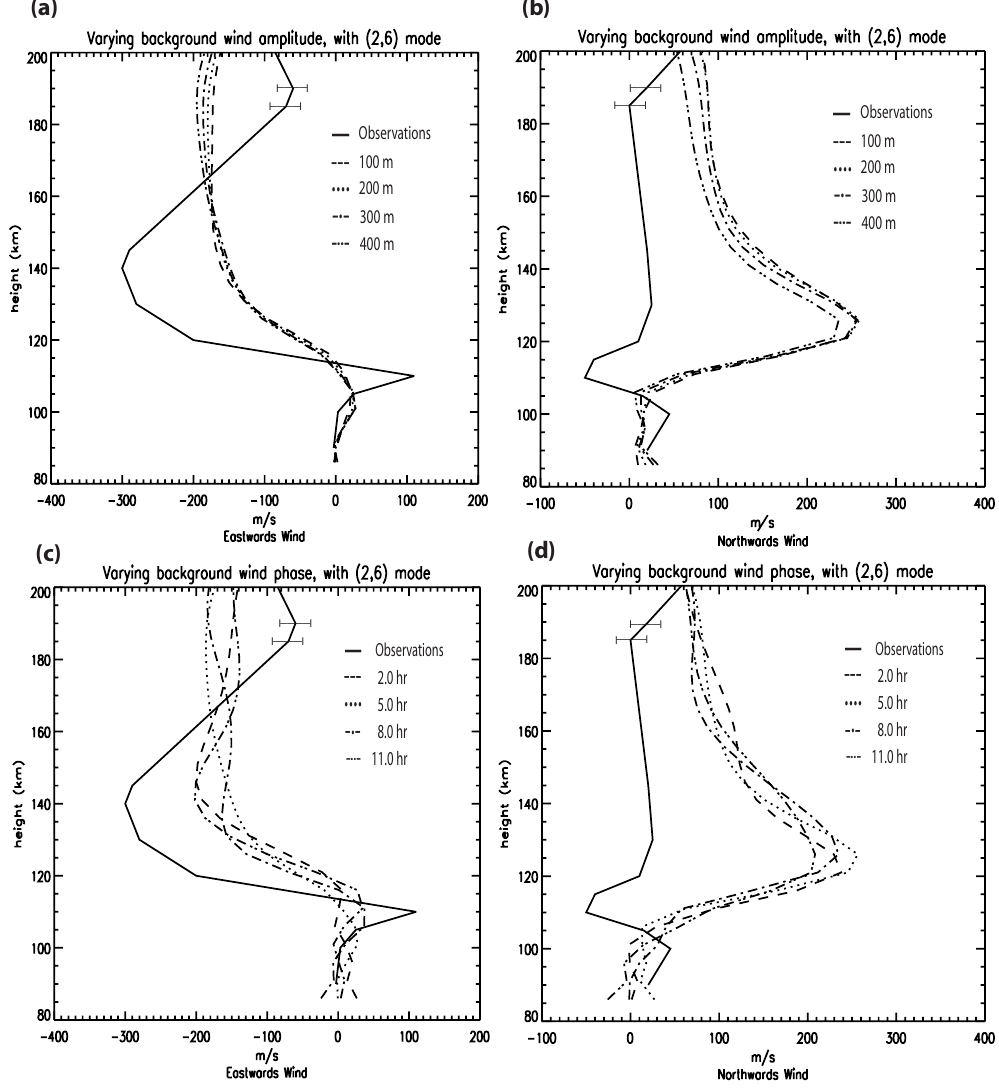
Fig. 6. (a) and (b) response of the neutral winds to changes in the amplitude of the (2,6) tidal mode in the background winds, (c) and (d) response of the neutral winds to changes in the phase of the (2,6) tidal mode in the background winds. Results are compared with the southern trail 28 February dusk side